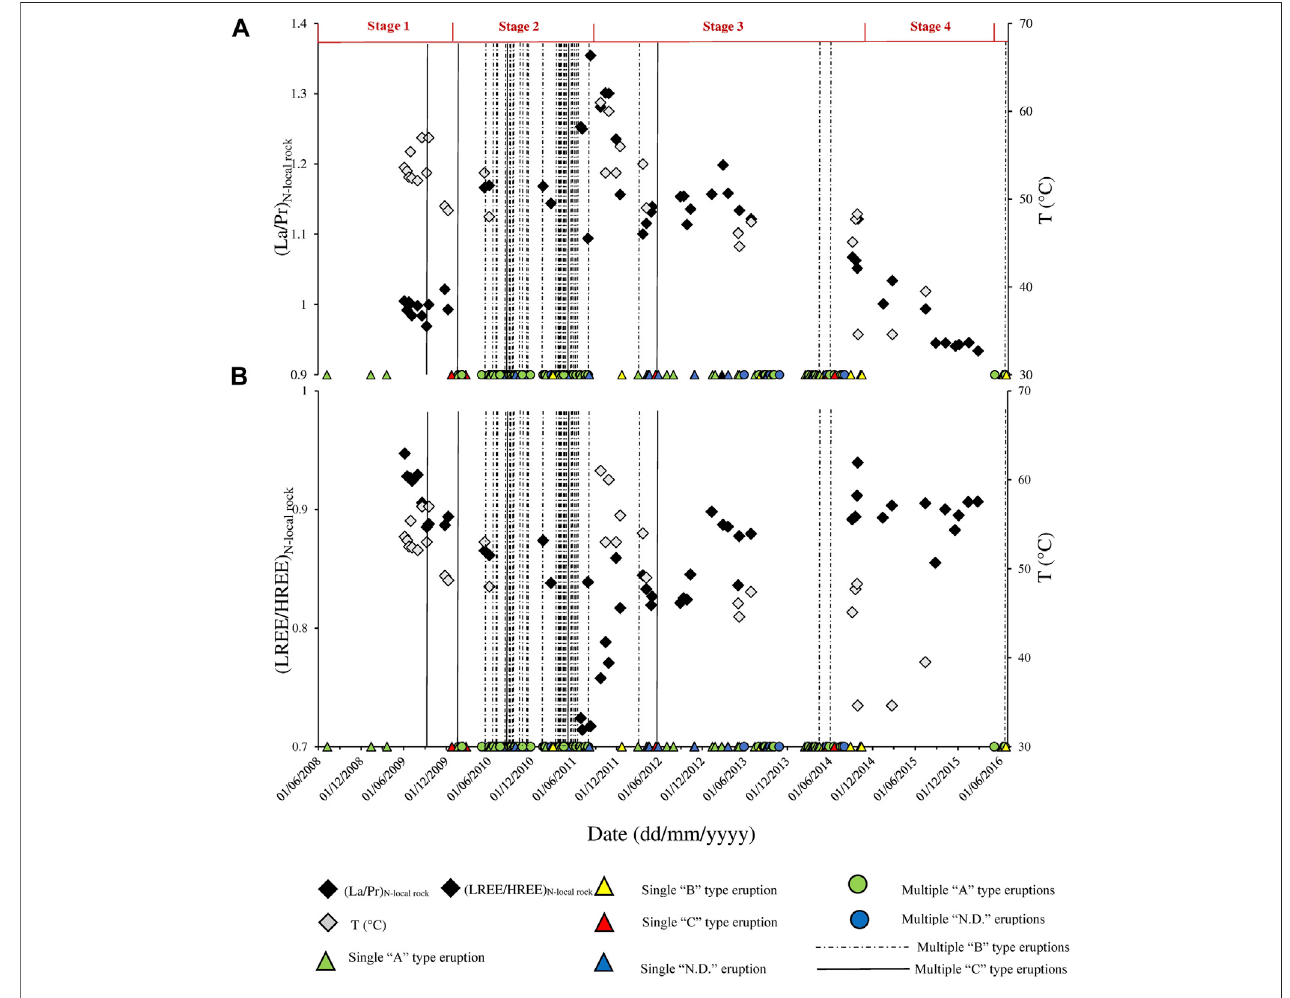
FIGURE 5 | (A) (La/Pr) N-local rock and T vs. time. (B) (LREE/HREE) N-local rock and T vs. time.